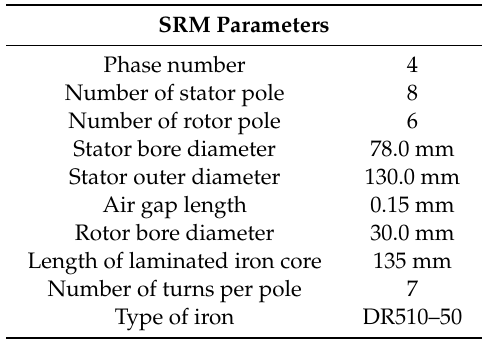
Table A1. Parameters of tested Switch Reluctance